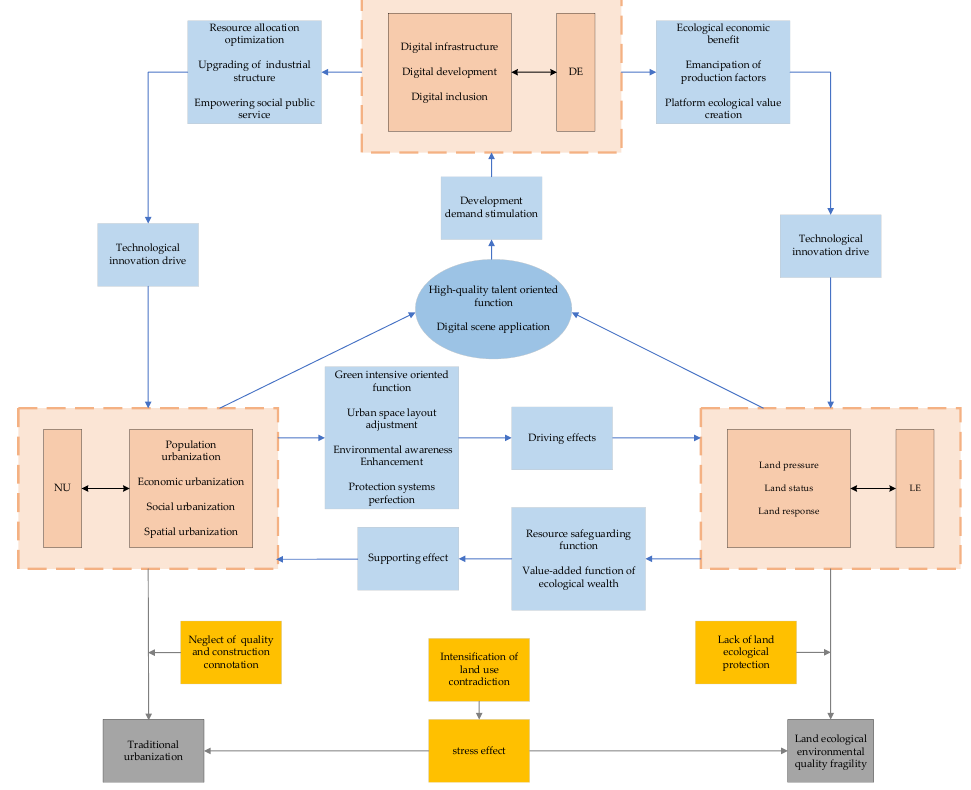
Figure 1. The coupling mechanism of DE – NU – LE.